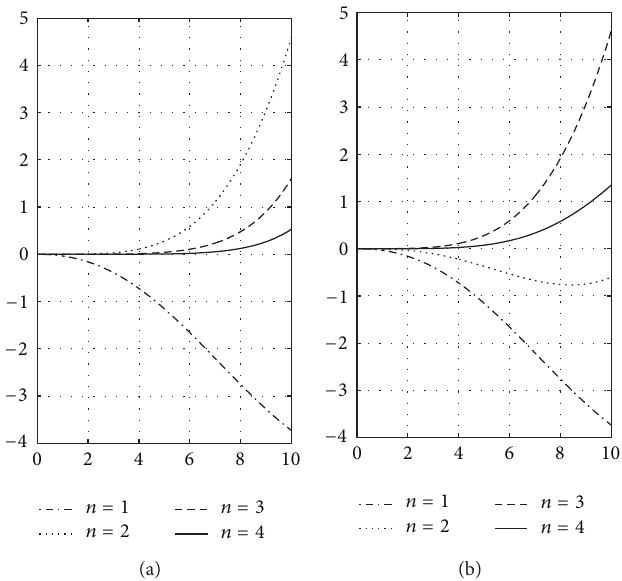
Figure 1: The error functions 𝐸 𝑛 (𝑡 𝑖 ) for Example 1: (a) present method and (b) standard